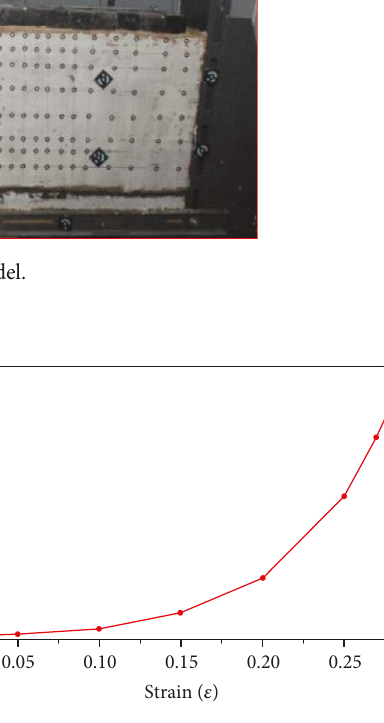
Figure 2: The gangue compression stress-strain